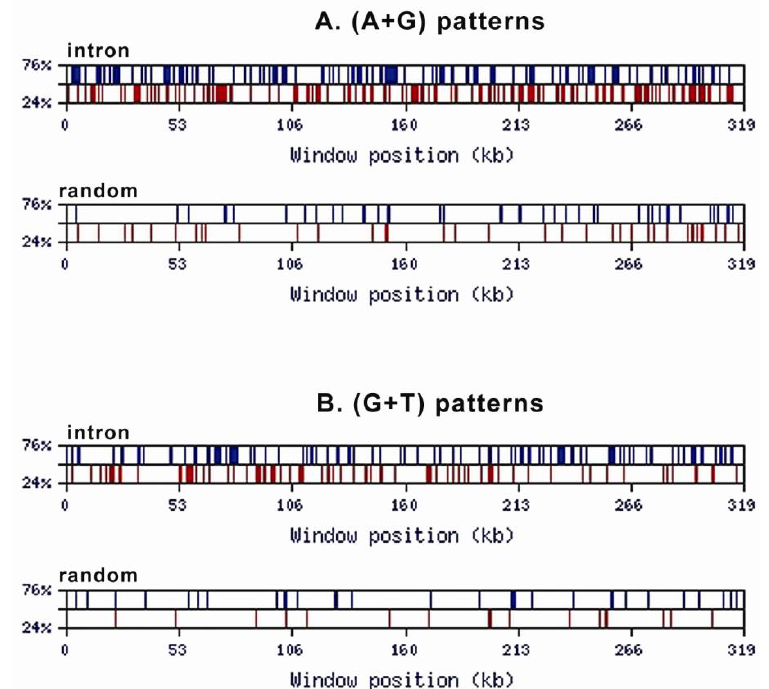
FIGURE 2. The graphical output of the MRI -analyzer program for the first intron of the dystrophin gene (marked as “intron”) and also for the SRI- generator random sequence based on the tetramer oligonucleotide frequency table of the intron (marked as “random”). The entire sequence of the 319-kb intron and the random sequence is displayed on the x axis. Blue bars represent content-rich MRI regions on the sequence. Red bars represent content-poor MRI regions. The y axis contains upper and lower thresholds for the given content type. (A) Genomic MRI analysis of A+G-rich and A+G-poor (or T+C-rich) regions; (B) Genomic MRI analysis of G+T-rich and G+T-poor (or C+A-rich)